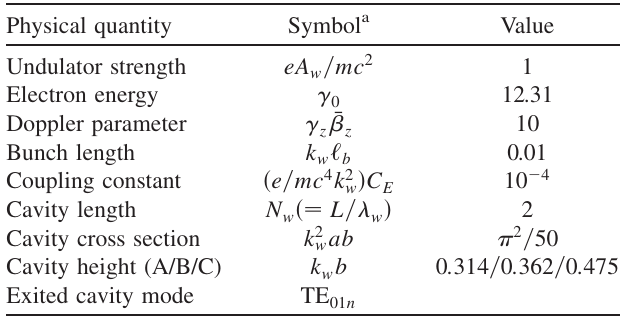
TABLE I. Input parameters used in